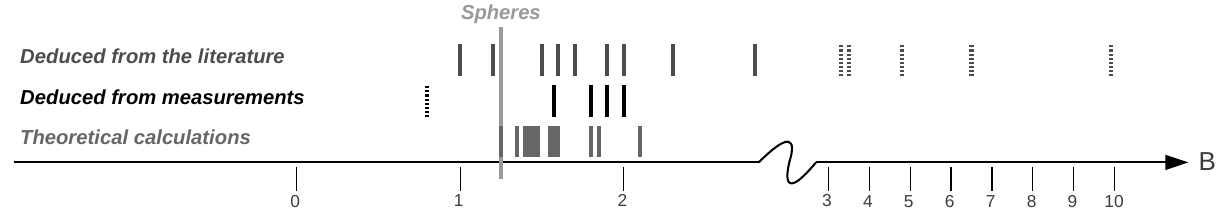
Fig. 6. Representation of all values of B determined from theoretical calculations, from measurements and from data in the literature. The dashed bars correspond to questionable